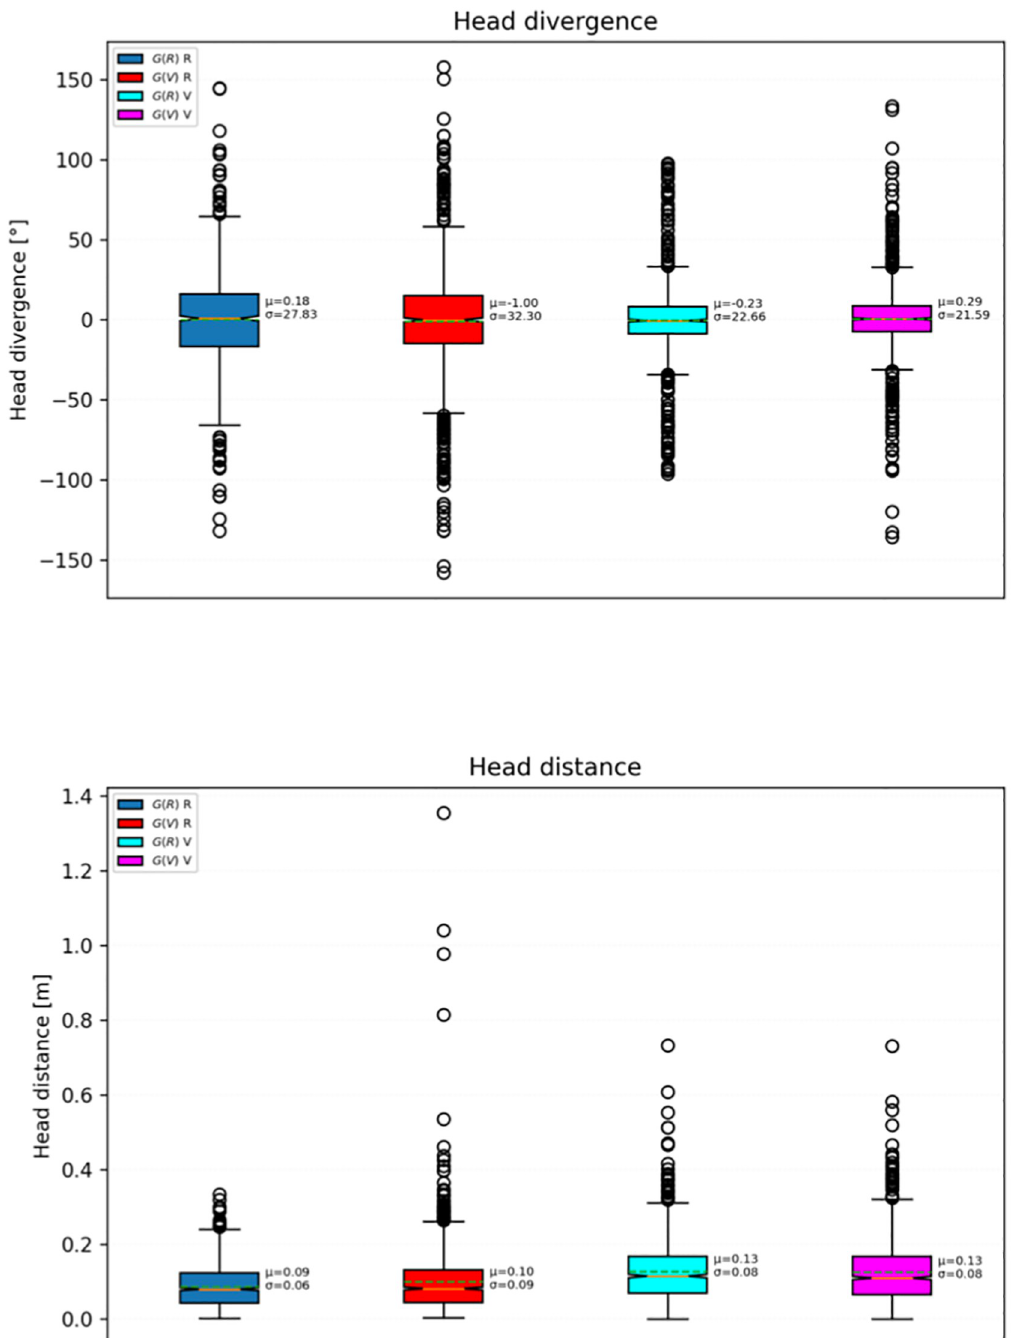
Fig 4. Head divergences and distances by group and